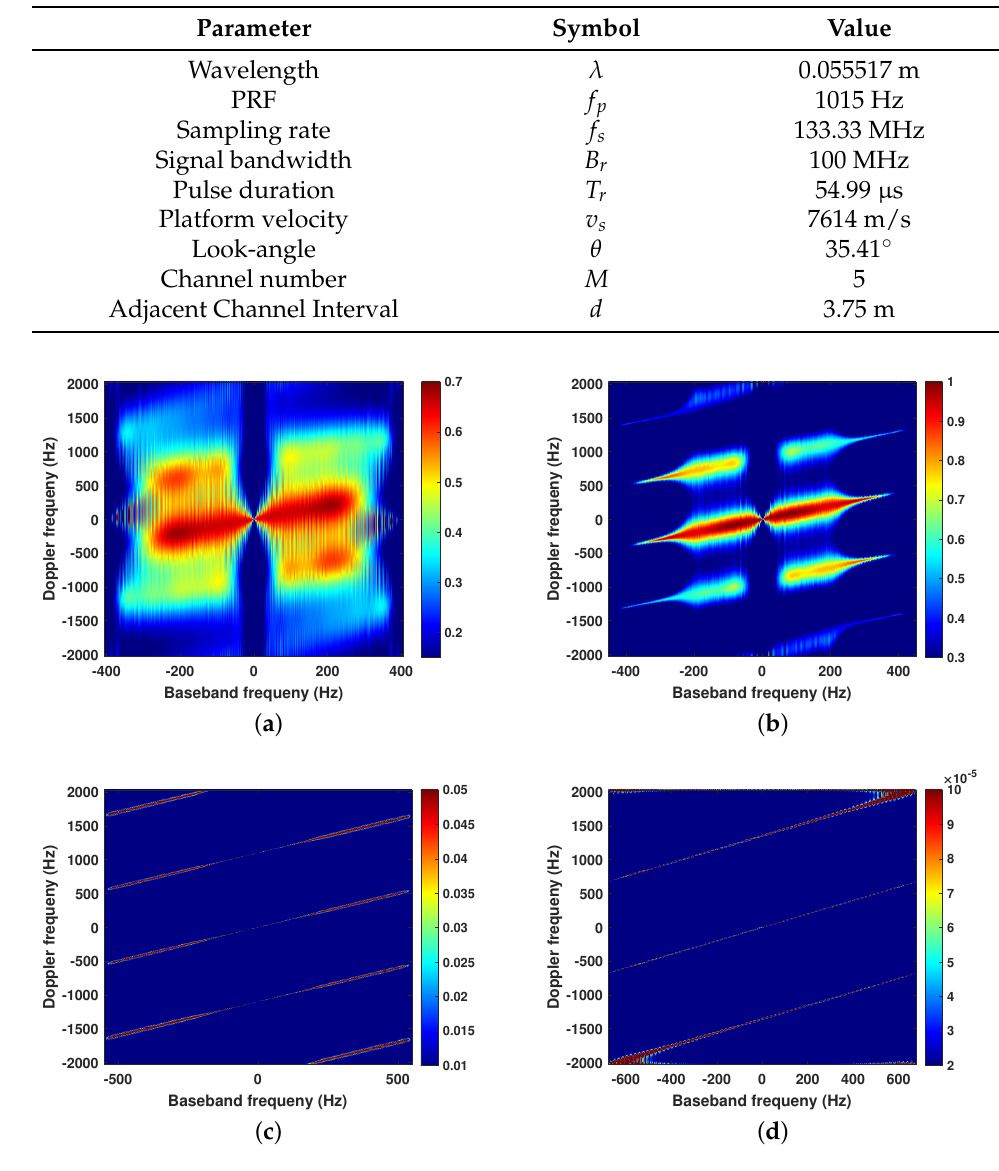
Figure 5. Doppler spectrum of five − channel SAR system versus PRF. ( a ) Sampling PRF = 813 Hz and corresponding to the index of ambiguity. ( b ) Sampling PRF = 903 Hz and corresponding to the index of ambiguity. ( c ) Sampling PRF = 1100 Hz and corresponding to the index of ambiguity. ( d ) Sampling PRF = 1357 Hz and corresponding to the index of